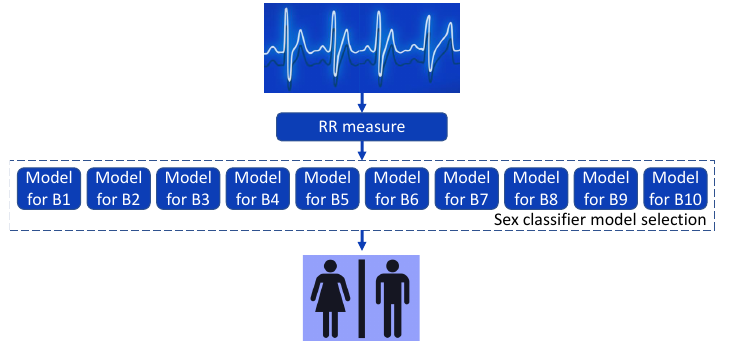
Figure 4. Heartbeat study